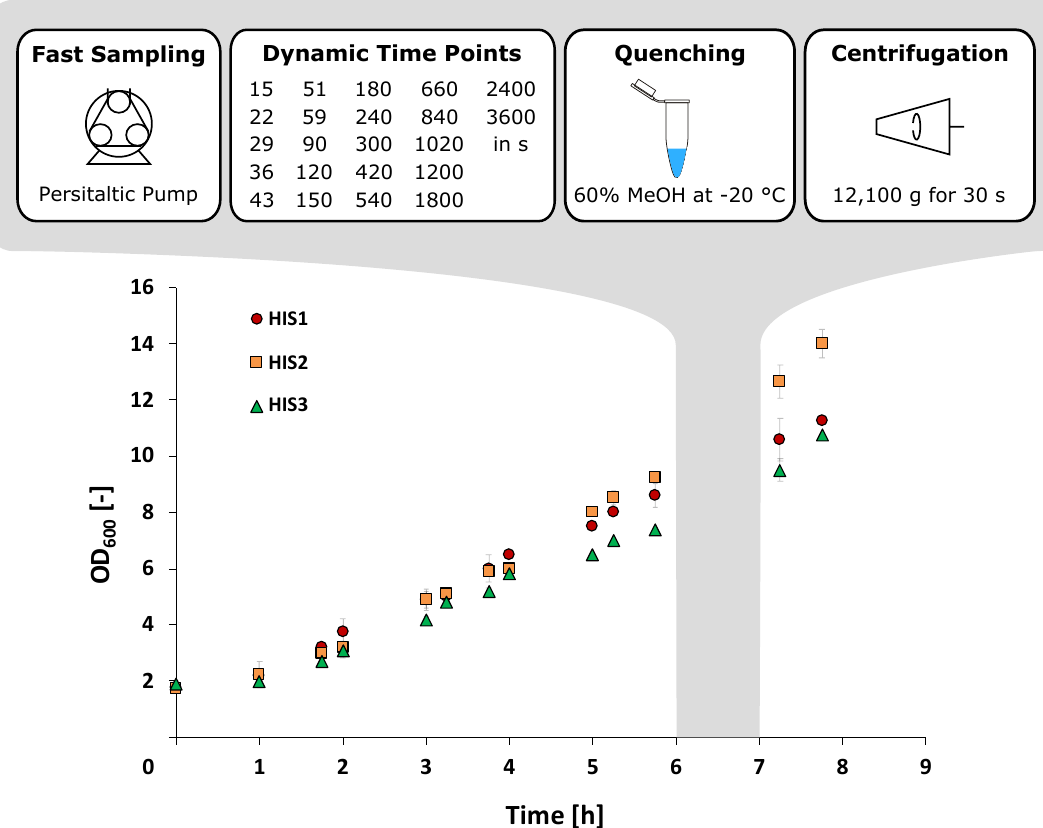
Figure 4. Growth curves of C. glutamicum HIS1, HIS2, and HIS3 during the tracer experiment and the schematic workflow of the fast sampling procedure. 13 C 5 -ribose was added after 6 h, and sampling was finished at the seven-hour mark. Error bars give the standard deviation of three independently performed experiments ( n =